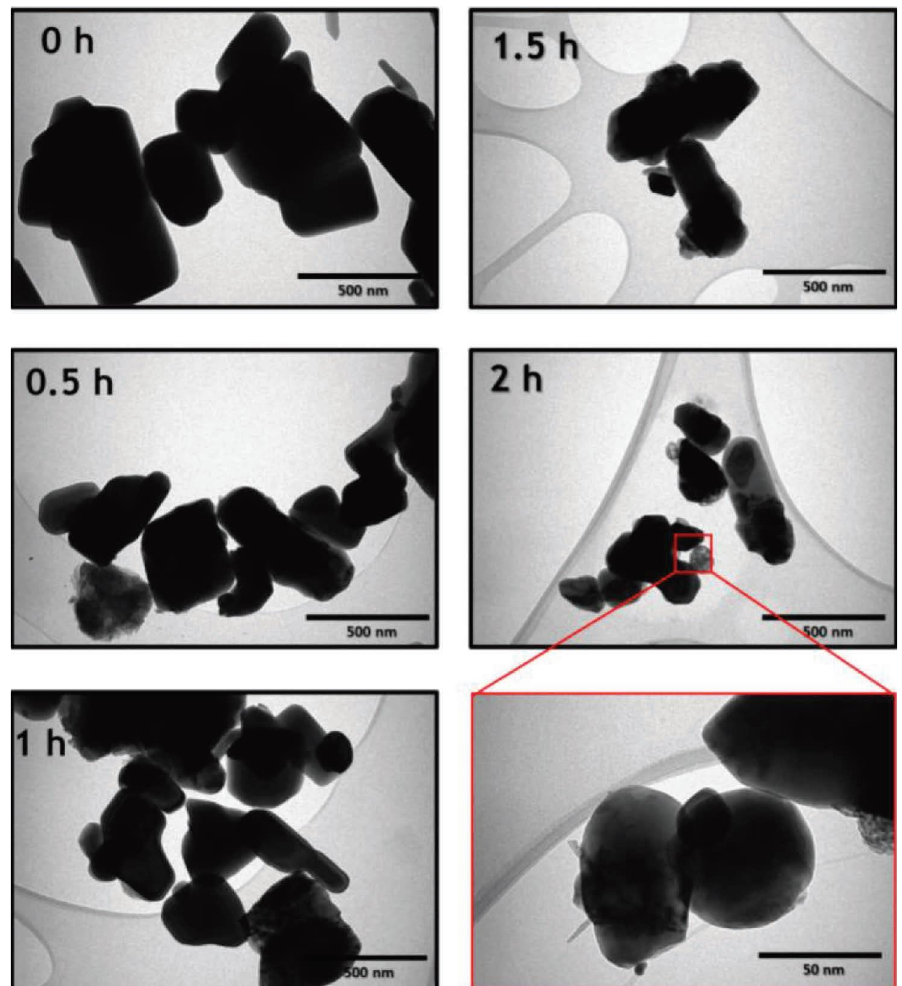
Figure 2: TEM micrographs of ZnO at diferent ball-milling times. 0h refers to the unmilled ZnO